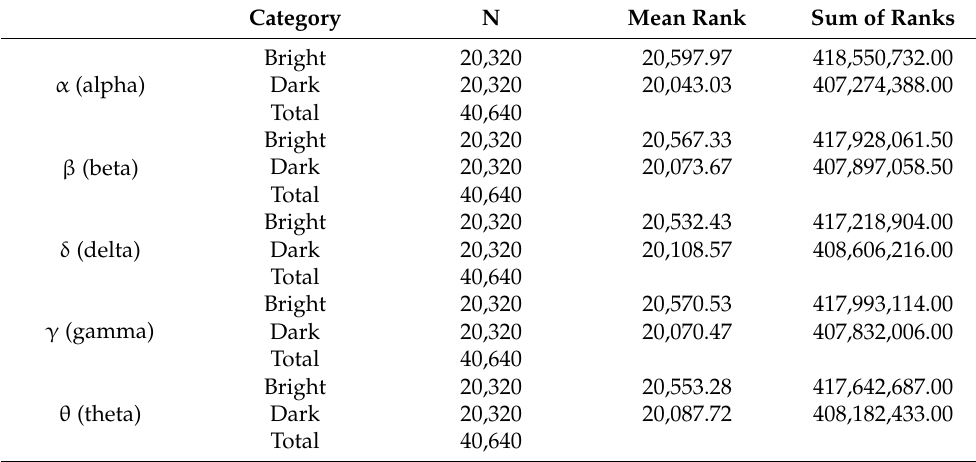
Table A4. Ranks of the mean band measurements related to the Bright and Dark categories for the Light